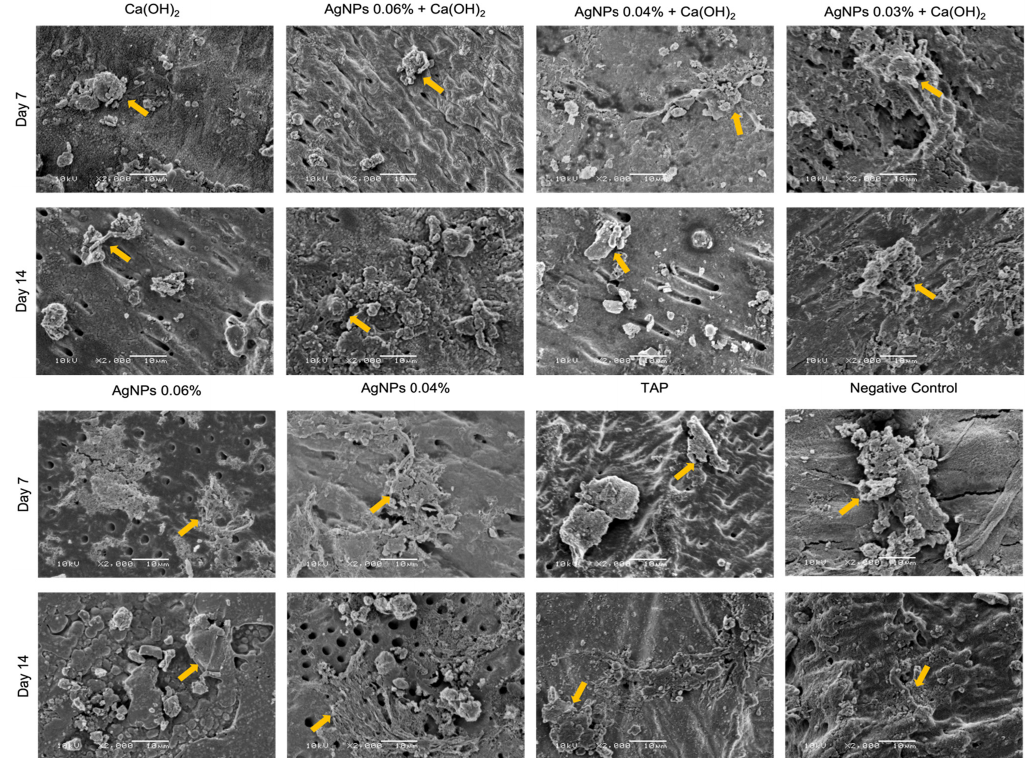
Figure 4. Representative SEM images of human mesenchymal stem cells grown on dentin disks that were immersed in the test medicaments for either 7 or 14 days. Yellow arrows point to mesenchymal stem cells. Scale bar: 10 µm, ×2000 magnification. [Ca(OH) 2 : Calcium hydroxide, AgNPs: Silver na- noparticles, TAP: Triple antibiotic paste].